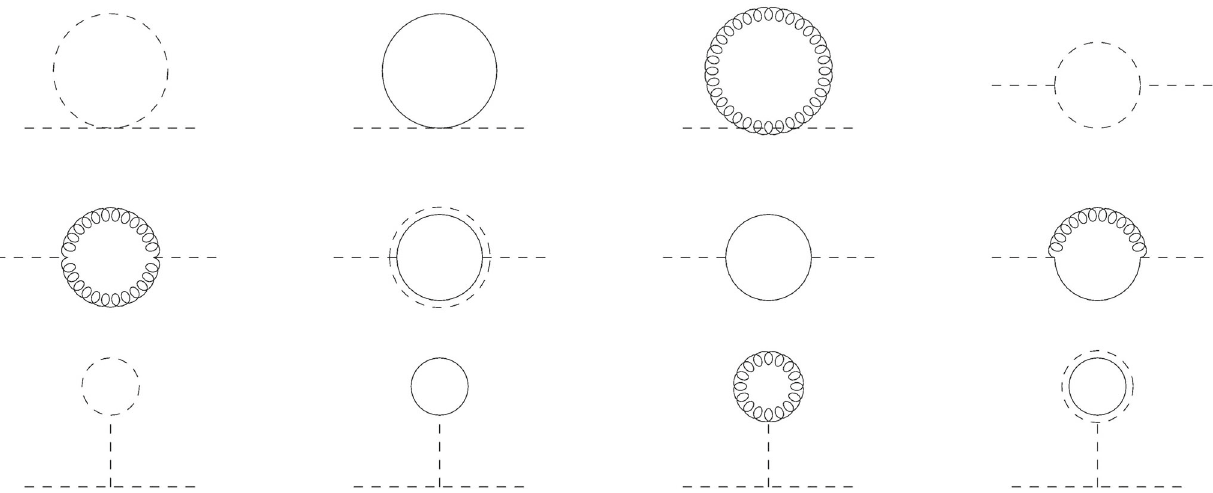
Fig. 8 One-loop contributions to the propagator (cid:2) h ( p ) h ( − p ) (cid:3) . Curly lines represent the gauge field, dashed lines the Higgs field, solid lines the Goldstone boson and double lines the ghost